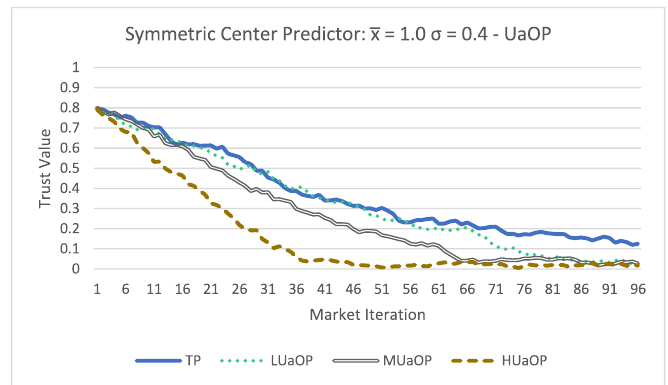
Figure 7. Asymmetric High Predictor.